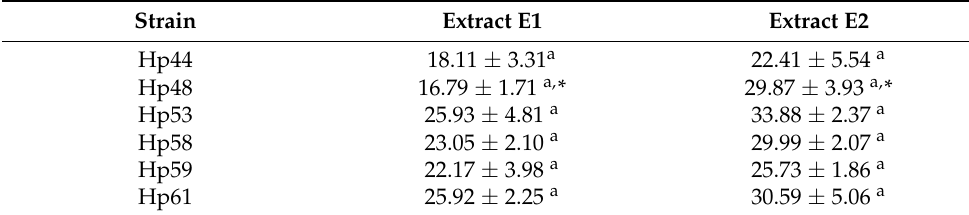
Table 3. Protective effect of olive-leaf extracts (E1 and E2) on intracellular ROS production by H. pylori -infected AGS cells. Values are expressed as % inhibition of ROS production (mean ± standard deviation) ( n =